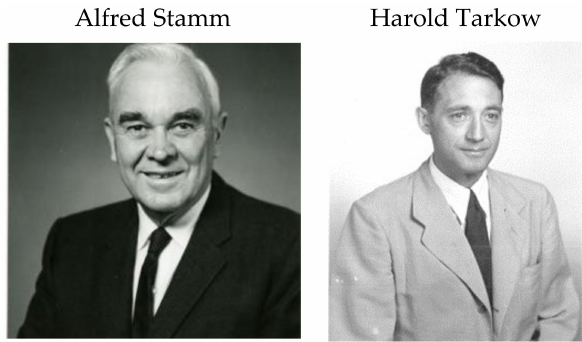
Figure 21. Photographs of Alfred Stamm and Harold